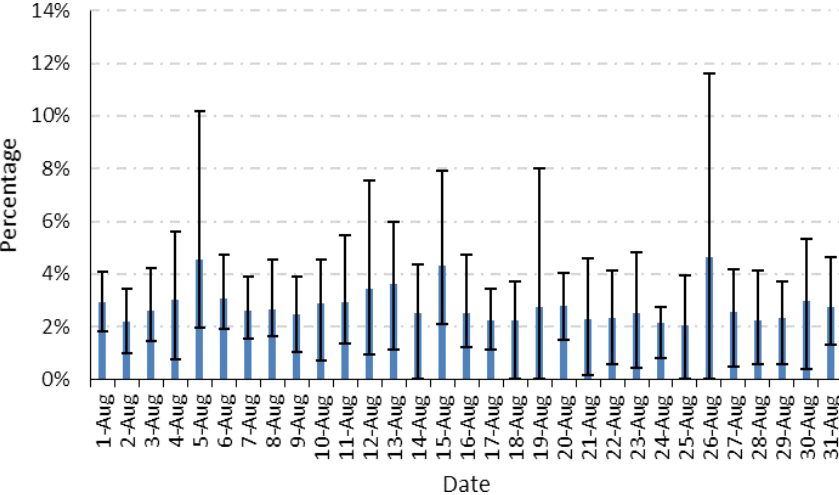
Figure 4: Shares of overloaded category 9 vehicles due to the axle loads, averaged for all stations, on particular measurement days (whiskers represent the minimum and maximum values)